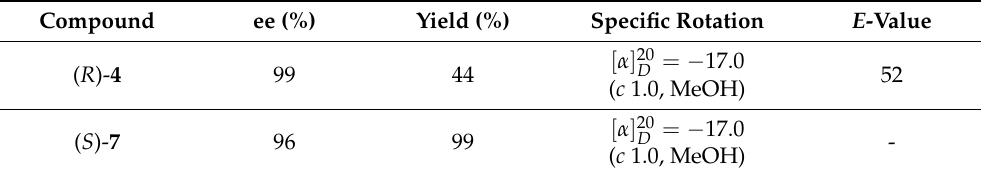
Table 1. E -values, ee-values, and yields of the enantiopure chlorohydrin ( R )- 4 and the drug ( S )- 7 . The kinetic resolutions were catalysed via CALB from syncozymes in dry acetonitrile. Specific rotations [𝛼] 𝐷𝑇 were determined at 20 °C in methanol with c = 1. For additional parameters, see Materials and Methods. The yields for each compound in the table are for each reaction step. The overall yield for ( S )-bisoprolol hemifumarate (( S )- 7 ) is 19%. Compound ee (%) Yield (%) Specific Rotation E -Value ( R )-